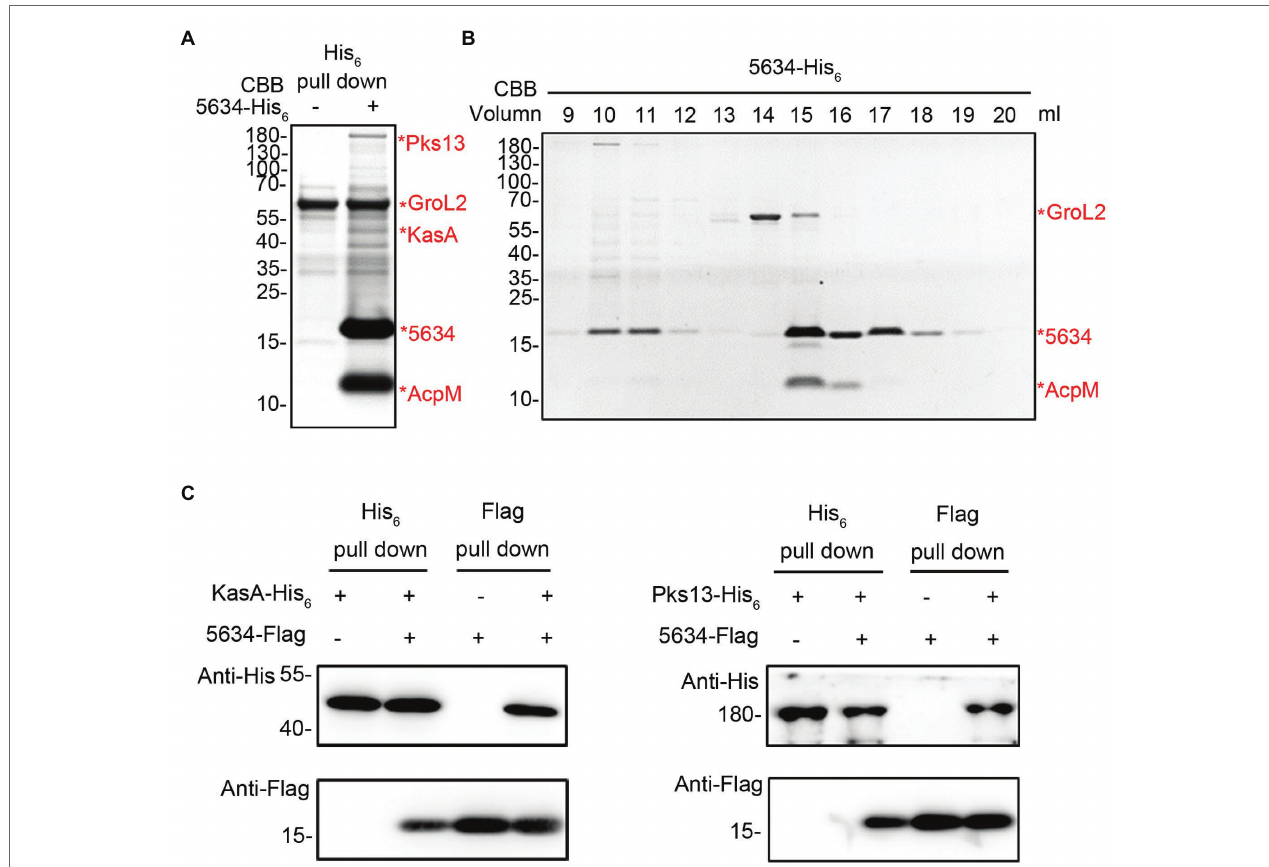
FIGURE 3 | Interactions between MSMEG_5634, AcpM, and FAS-II components. (A) Identification of proteins interacting with MSMEG_5634 in Mycobacterium smegmatis .